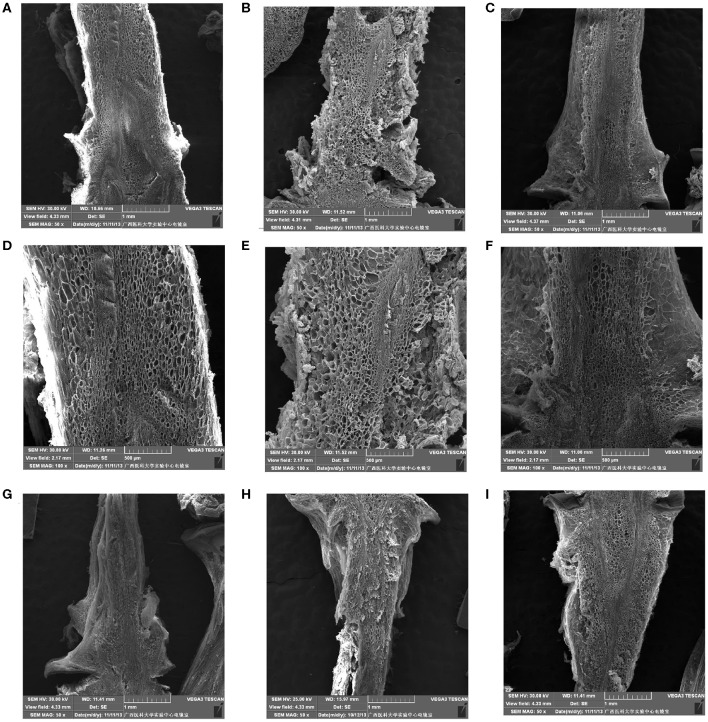
The ultrastructure of berry brush cells of table grapes stored for 0 or 6 days. After storage for 0 day in “Muscat Kyoho” (×50) (A), “Kyoho” (×50) (B), and “Nanyu” (×50) (C); after storage for 0 day in “Muscat Kyoho” (×100) (D), “Kyoho” (×100) (E), and “Nanyu” (×100) (F); after storage for 6 days in “Muscat Kyoho” (×50) (G), “‘Kyoho” (×50) (H), and “Nanyu” (×50) (I). All images are of transverse sections.